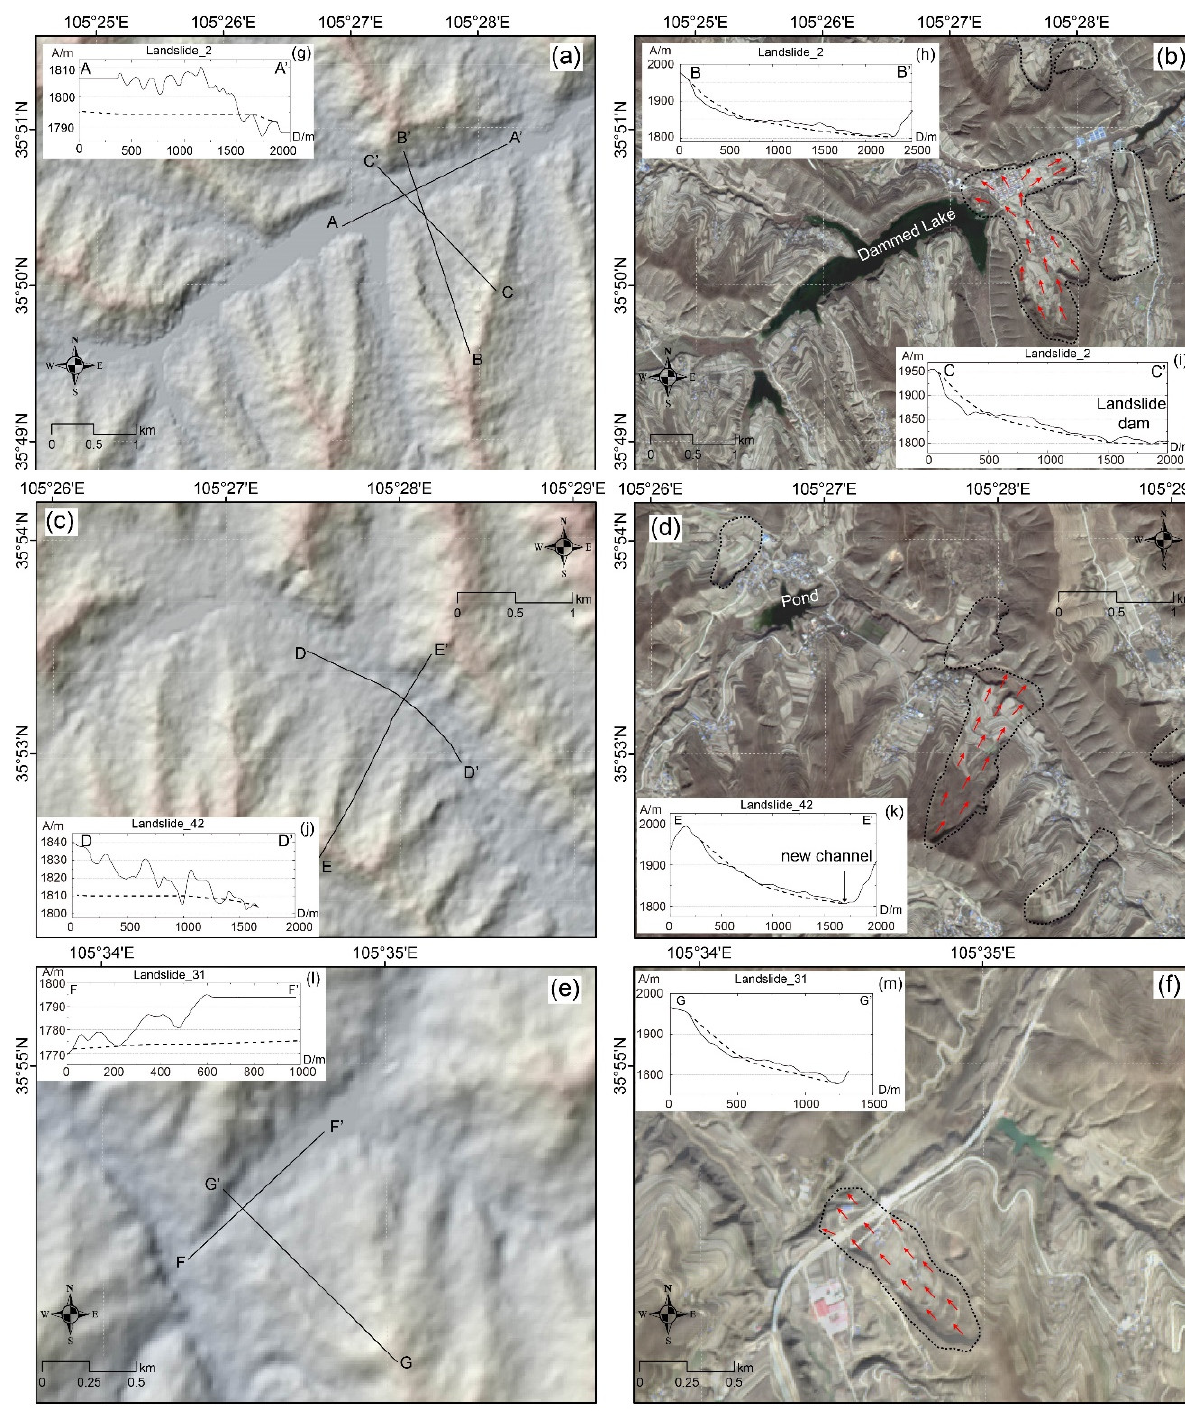
Figure 8. GF-1 Images and ALOS DEM showing the representative damming landslides. ( a , b ) Damming landslide of which the dam is well-reserved (Landslide_2 in Figure 7). ( c , d ) Damming landslide of which the dam is abandoned (Landslide_42 in Figure 7). ( e , f ) Damming landslide of which the dam has been artificially modified (Landslide_31 in Figure 7). ( g – i ) Thick dashed lines in the profiles denote the possible previous surface prior to the Landslide_2. ( j , k ) Thick dashed lines in the profiles denote the possible previous surface prior to the Landslide_42. ( l , m ) Thick dashed lines in the profiles denote the possible previous surface prior to the Landslide_31. The red arrows show the direction of movement.